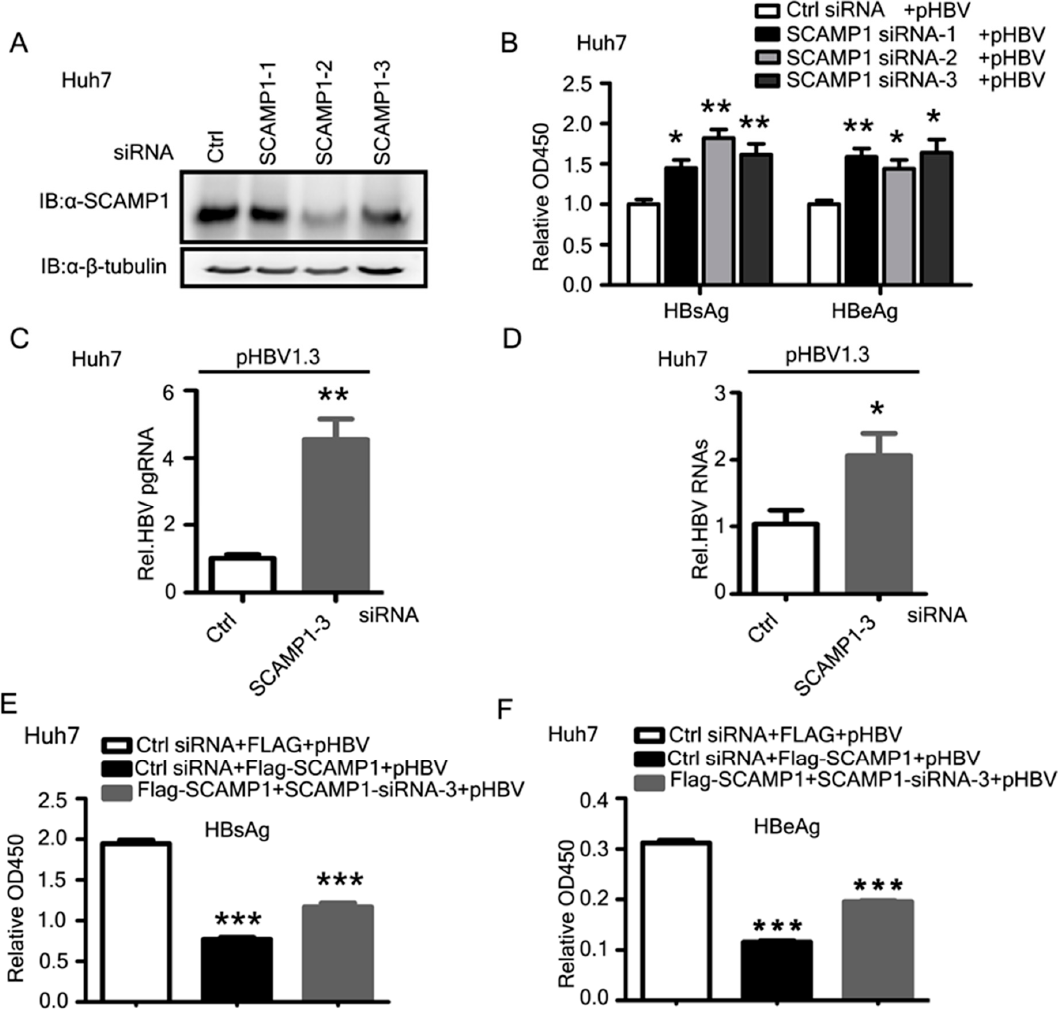
Figure 7. Knockdown of endogenous SCAMP1 leads to increased HBV replication. ( A ) Immunoblot analysis of SCAMP1 knockdown in Huh7 cells treated with SCAMP1-specific siRNAs or control (Ctrl) siRNA, β -tubulin serves as a loading control in all analyses. ( B – D ) ELISA analysis of secreted HBsAg and HBeAg ( B ) and Real-time PCR analysis of pgRNA ( C ) and HBV RNAs ( D ) in Huh7 cells, transfected with SCAMP1-specific siRNAs or control (Ctrl) siRNA or pHBV1.3, are shown. ( E , F ) The siRNA rescue experiment was performed in Huh7 cells, transfected with SCAMP1-specific siRNA or control (Ctrl) siRNA or pHBV1.3, together with pEF-FLAG or FLAG-SCAMP1, are shown. The complementation of SCAMP1 efficiently restored the amount of secreted HBsAg ( E ) and HBeAg ( F ), as determined by ELISA, (0.01 * p < 0.05; 0.001 < ** p < 0.01; and *** p < 0.001).